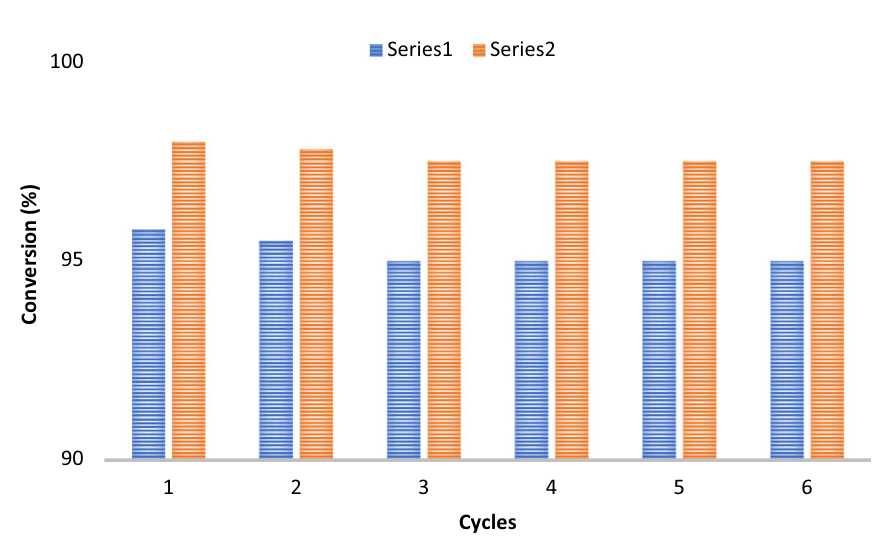
Figure 12. Recyclability of SF@GOC after catalytic reaction with Orange (II) (Series 1) and Eosin Y (Series